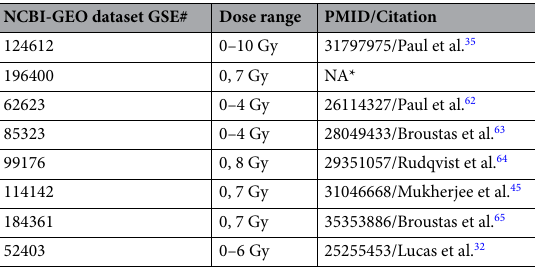
Table 1. Microarray data used for meta-analyses with GEO accession numbers and citations. *NA study information not